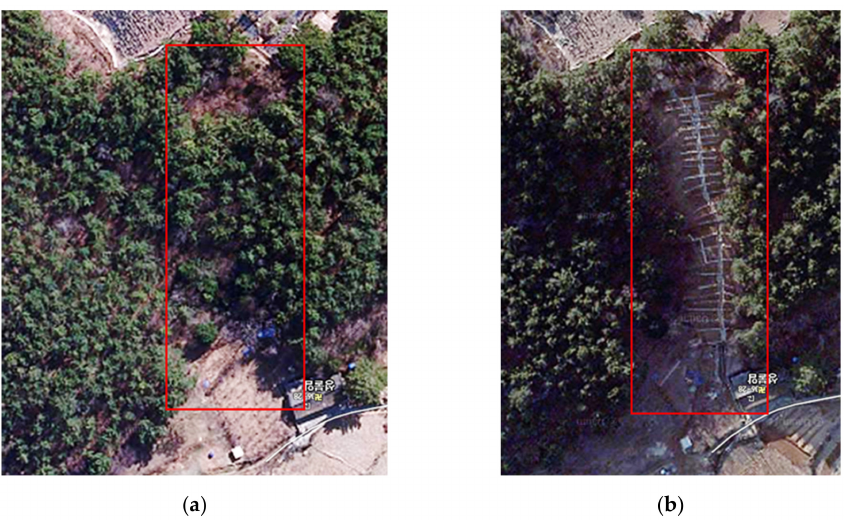
Figure 7. Explanation of the indirect field-check method using map services from a web portal [35], with aerial photographs taken ( a ) before and ( b ) after landslide